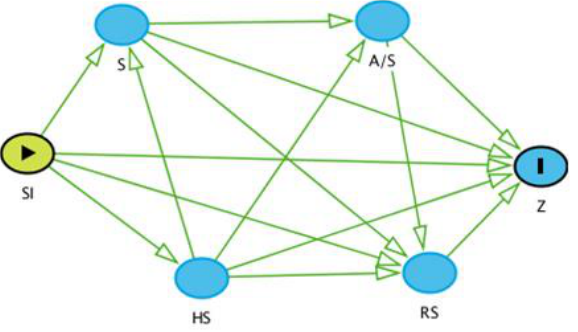
Figure 2. A causal diagram of the potential risk factors with the outcome variable (Z), which is seropositivity. SI: Site; S: Species; A/S: Age/Sex; RS: Reproductive Status; HS: Herd Size.